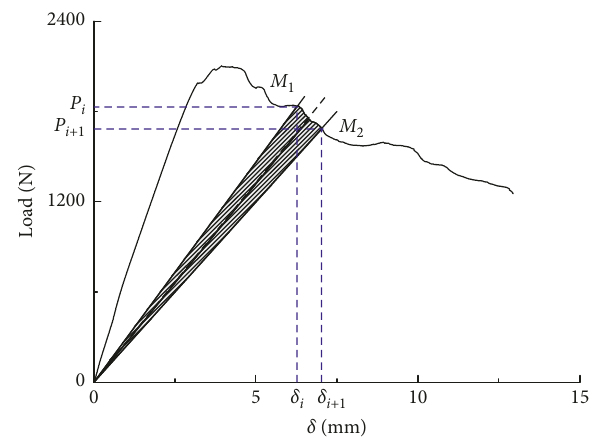
Figure 2: Schematic diagram of the evaluation of the resistance to crack growth ( G R